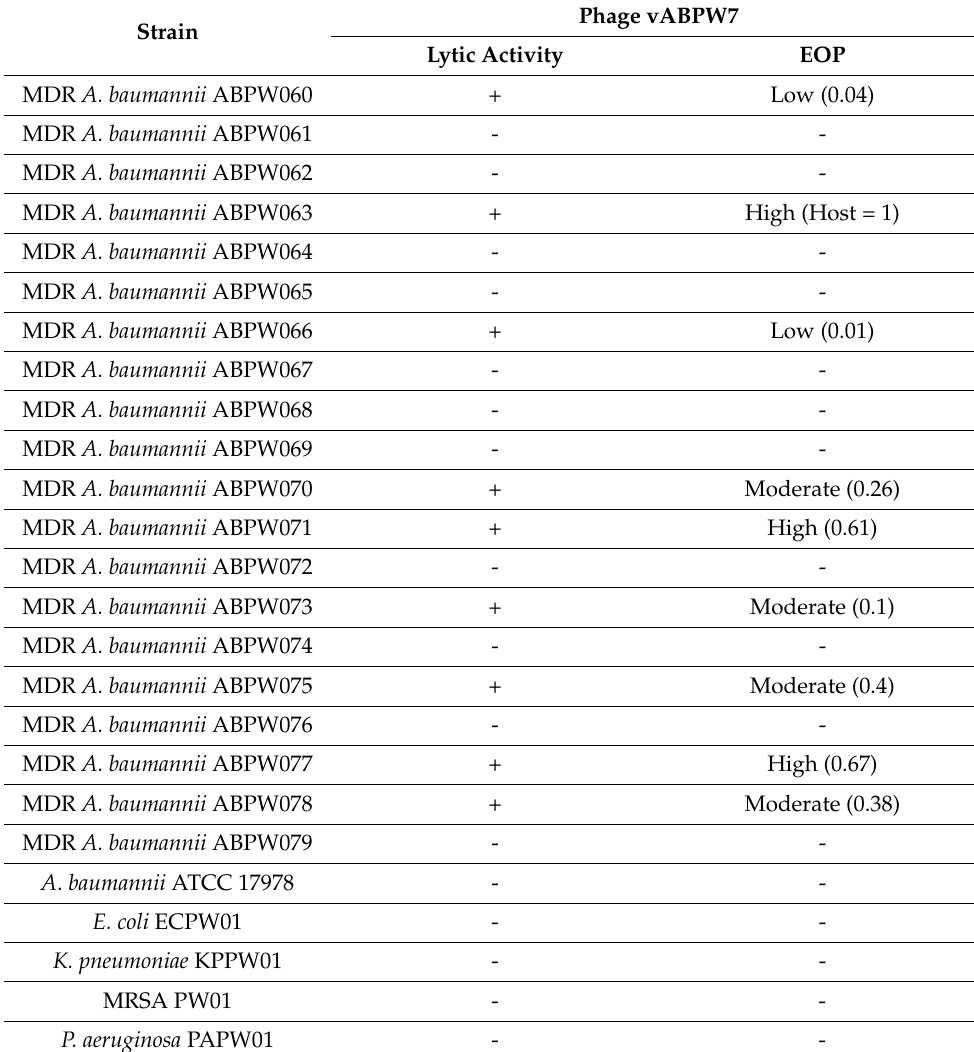
Table 1. Host range infection and EOP of phage